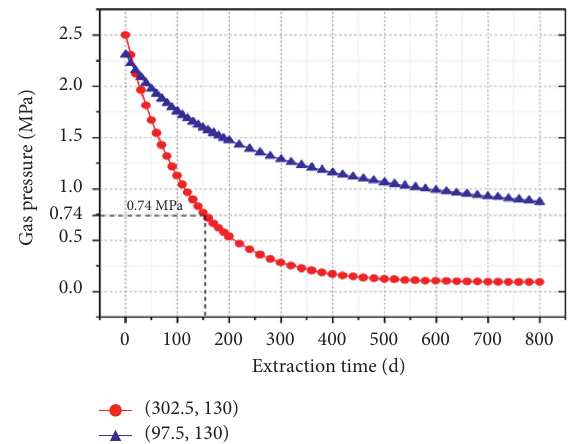
Figure 6: Gas pressure changes with time at different monitoring